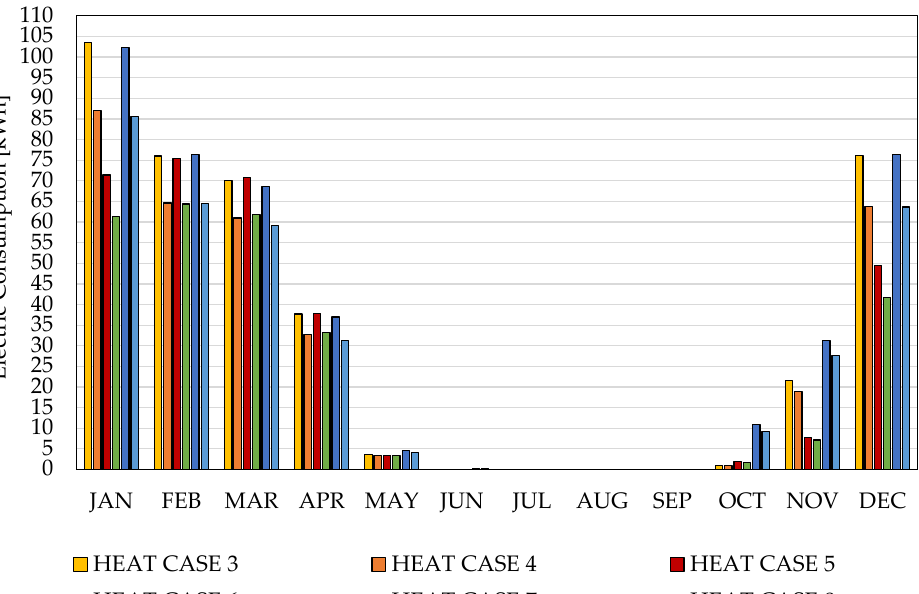
Figure 17. Monthly electricity consumption for different cases in heating mode.